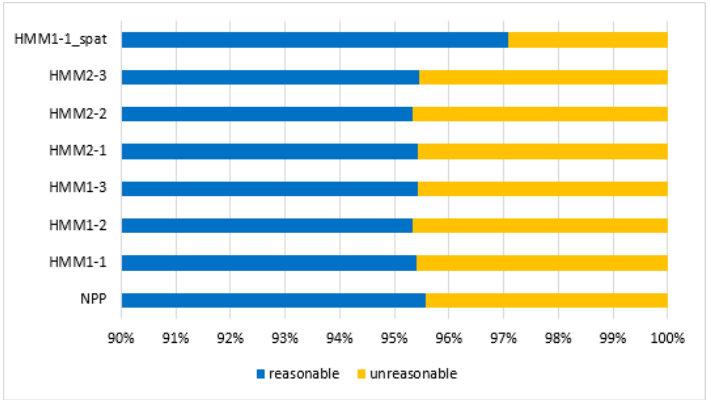
Figure 9. 100% stacked bar chart showing the proportion of unreasonable spatial distribution, 2007– 2015.